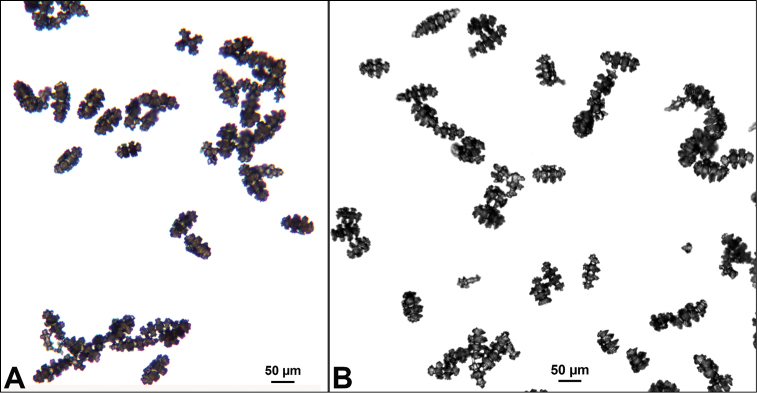
Eugorgialjubenkovia sp. nov., SBMNH 472232, light microscopy sclerite array. A 10×, showing rounded spindles and double discs. Note apparent quadriradiate, upper right B Sclerite array at 10×, illustrating stout, sharp-toothed double discs (seen in some species of Eugorgia). Sclerite color is white, but may give colony a very, very pale pink cast when in the tissue. Largest sclerites up to 100 µm, those shorter, rounder up to 70–75 µm.